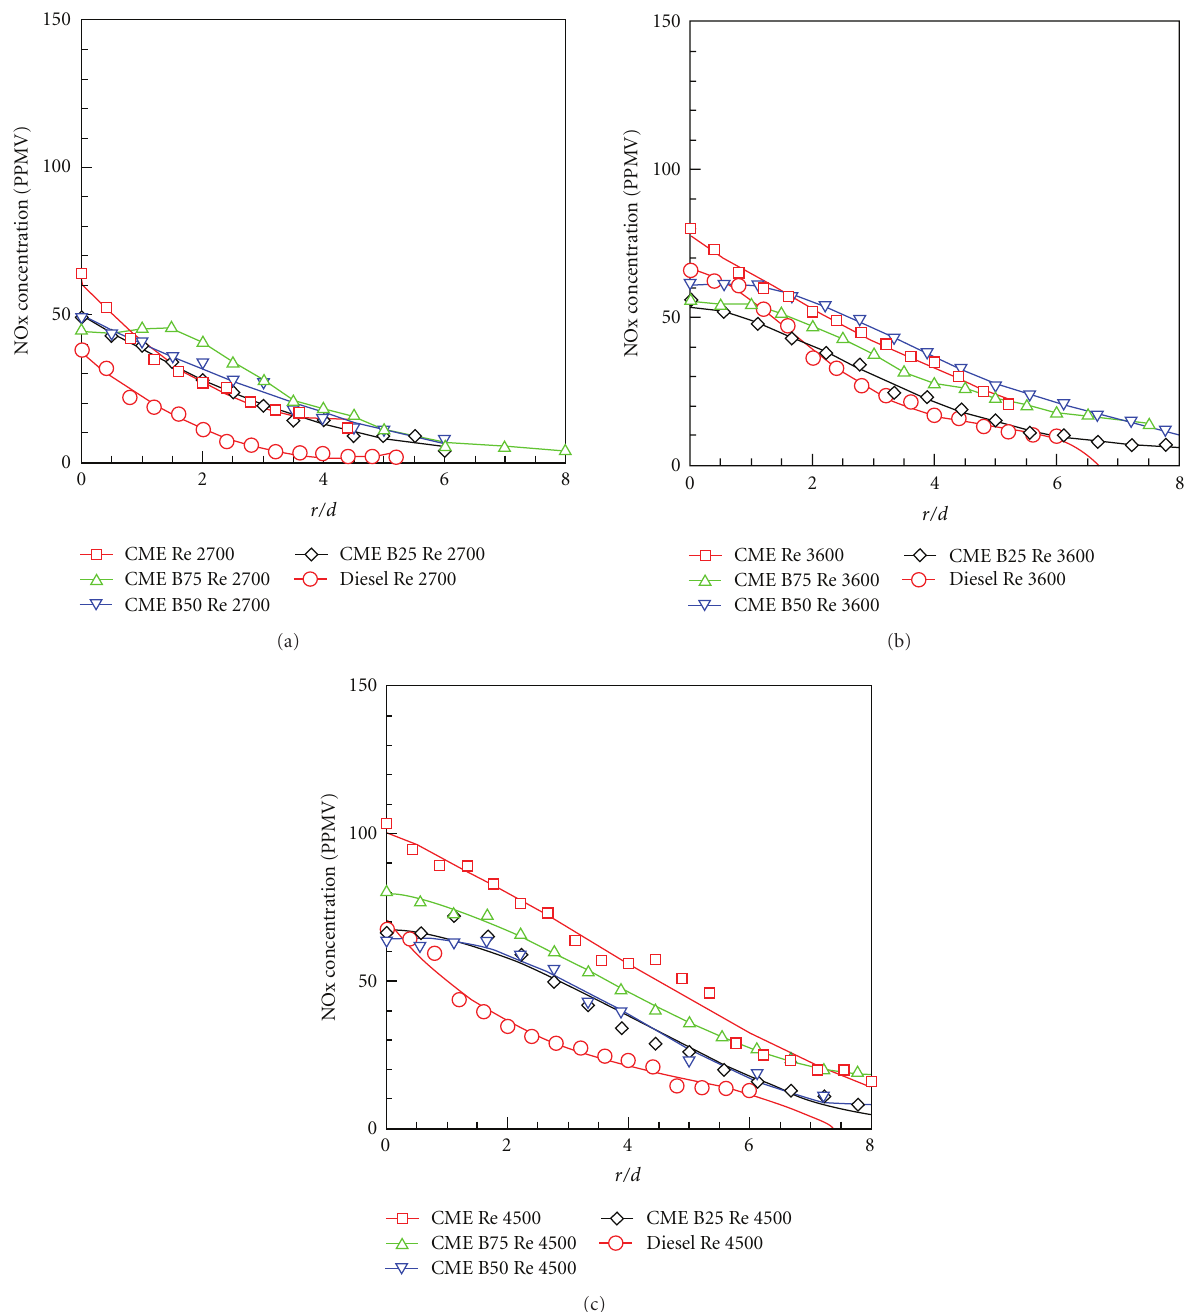
Figure 12: Radial profiles of NOx concentrations in the flames at three-quarter flame